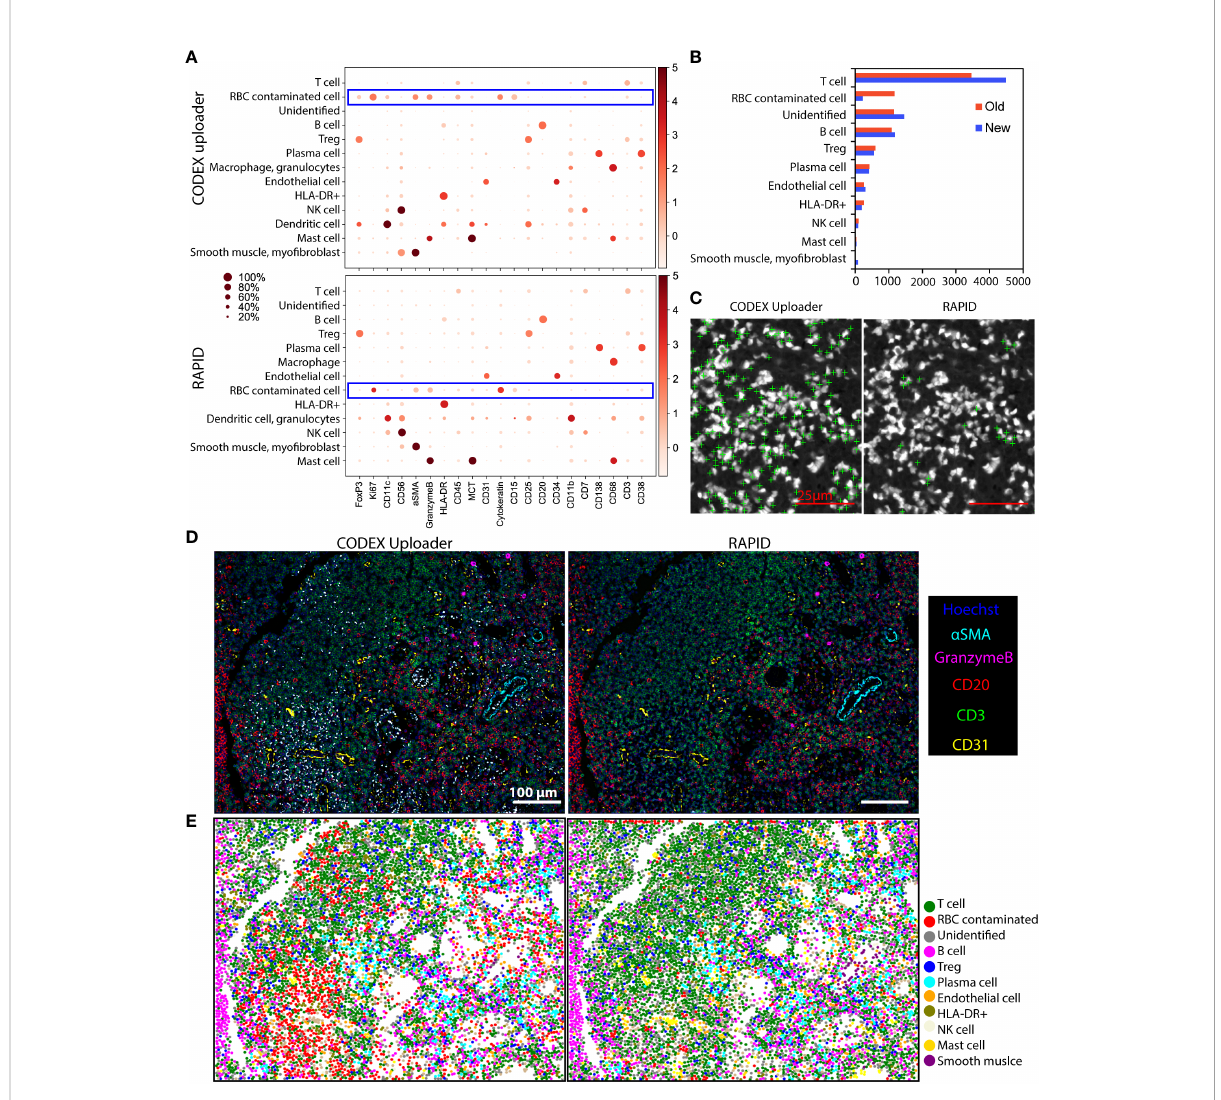
FIGURE 5 RAPID improves down-stream cell-type identi fi cation. (A) Unsupervised clustering and cell-type annotation of CODEX data processed using the CODEX Uploader (total number of cells = 8967) and RAPID (total number of cells = 9597). (B) Bar graphs of the numbers of annotated cells identi fi ed by the two pipelines. (C) Overlays of a blank image (Cy3 channel) with cell centroids (green crosses) assigned to the RBC- contaminated cell clusters after processing with the two pipelines. (D) Overlays of Hoechst nuclear stain with CD3, CD20, CD31, a SMA, and Granzyme B stainings of images processed with CODEX Uploader and with RAPID. Noise from RBC auto fl uorescence is indicated by white (due to overlay of all colors). (E) Scatter plots of x/y coordinates of cell centroids showing the spatial distribution of the annotated clusters in the tissue. Centroids of cells from the RBC contaminated cluster (orange) co-localize with white spots in images in panel (D)